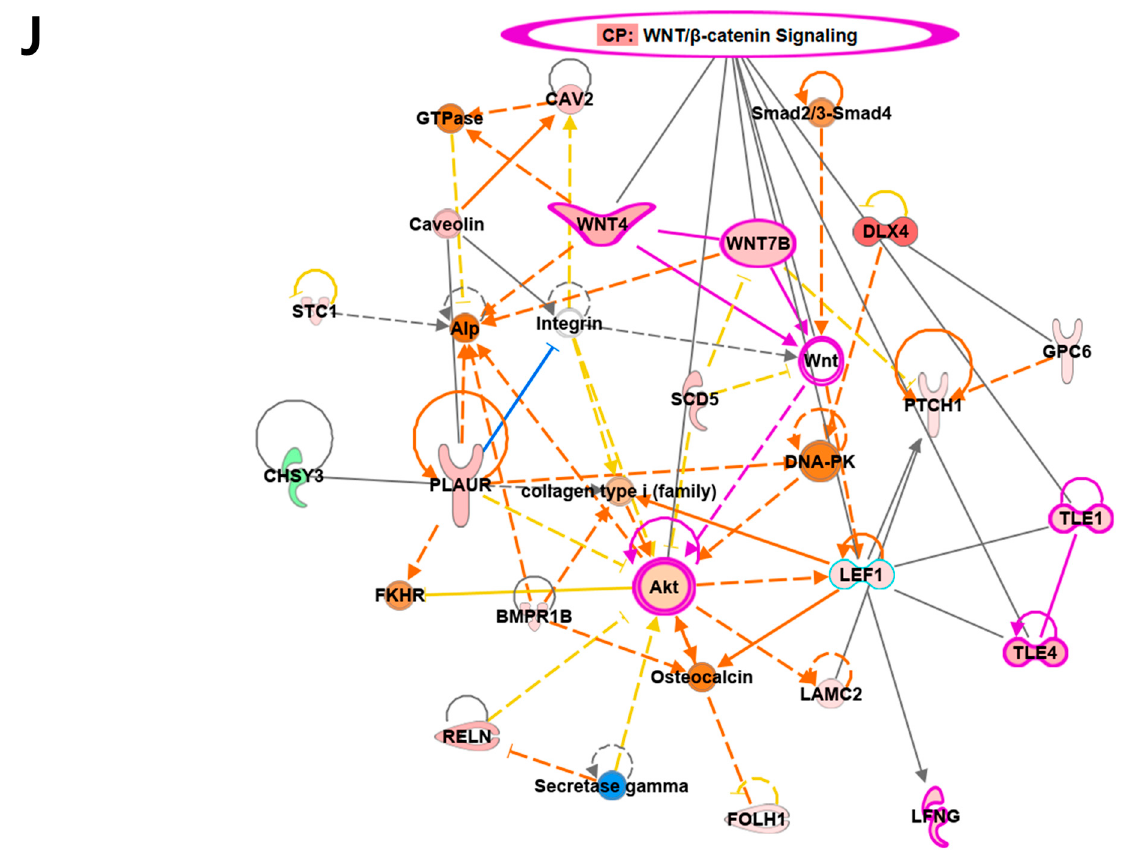
Figure 2. Overview of transcriptome profiles between 22Rv1 cells and hypoxia-resistant cells. ( A ) Schematic outline of RNA sequencing in 22Rv1 cells or hypoxia-resistant cells. ( B , C ) Volcano plot in 22rv1-CI and 22rv1-PCI displaying fold change versus adjusted p -values. Red dots represent the significant DEGs (|FC| > 1.5, p -value < 0.05). ( D ) GSEA enrichment score curve of hypoxia- or migration-related genes in 22rv1-CI. ( E ) Top significantly affected canonical pathway analysis in 22rv1-CI. ( F ) Gene network analysis associated with hypoxia and wound healing signaling in 22rv1-CI. Red, upregulated; green, downregulated. ( G ) Representative gene networks of Col13A1 in 22rv1-CI. ( H ) Top significantly affected canonical pathway analysis in 22rv1-PCI. ( I ) PTEN canonical pathway in 22rv1-PCI. ( J ) Wnt pathway in 22rv1-PCI.